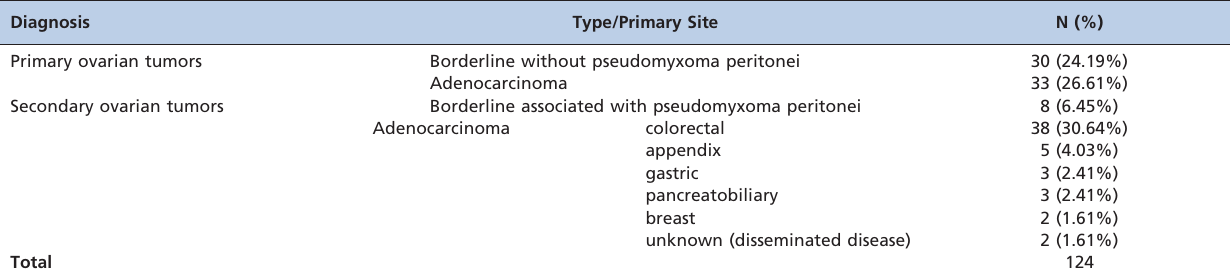
Table 1 - Distribution of the mucinous ovarian tumors included in this study.